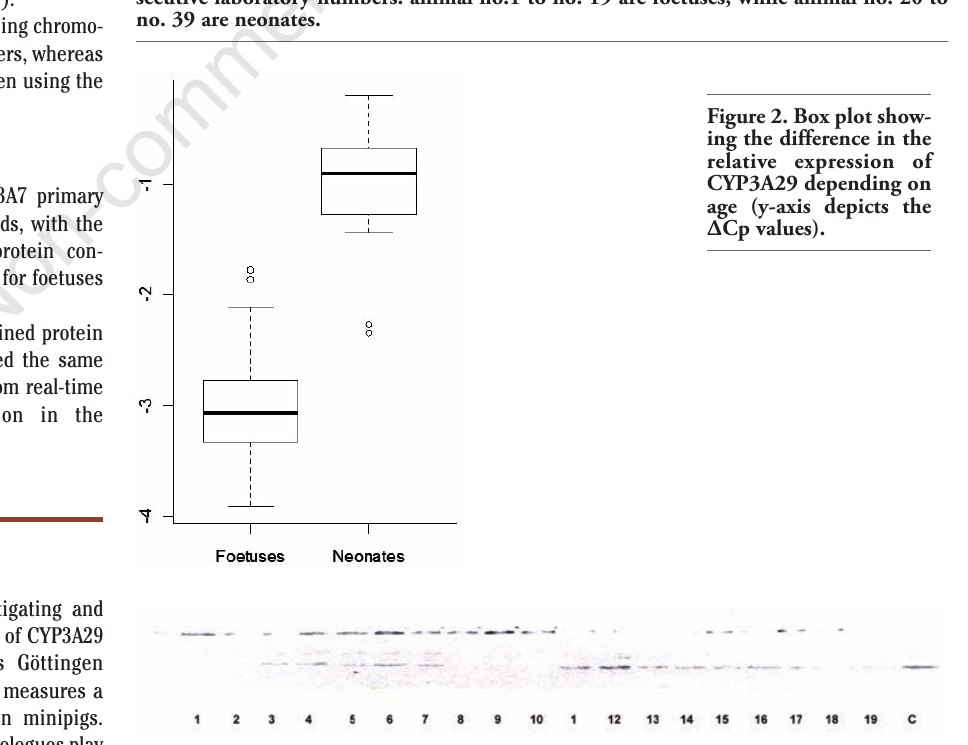
Figure 1. The relative expression of CYP3A29 for each individual Göttingen minipig depicted according to sex (pink: female, light blue: male). The animals were assigned con-